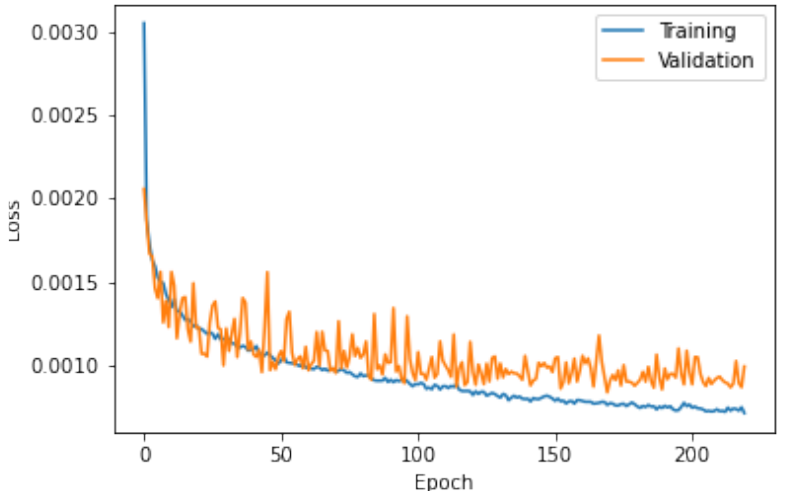
Figure 5. Evolution of loss function during training of LSTM-4 neural network model for one-hour- ahead PM 2.5 prediction of station Cerro Navia using the 6 closest stations as